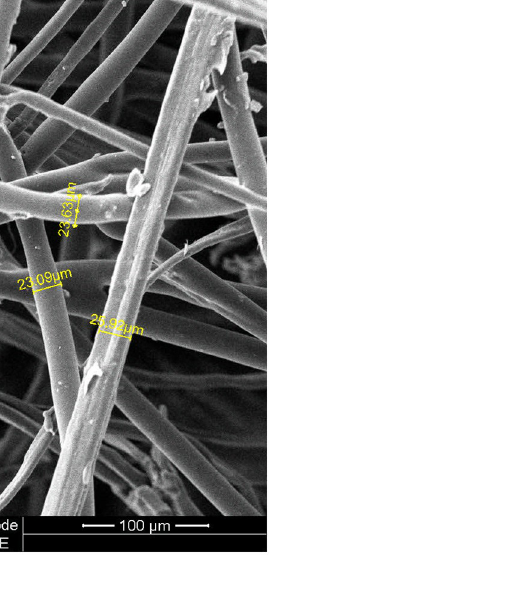
Fig 2. SEM photograph of the jute fiber